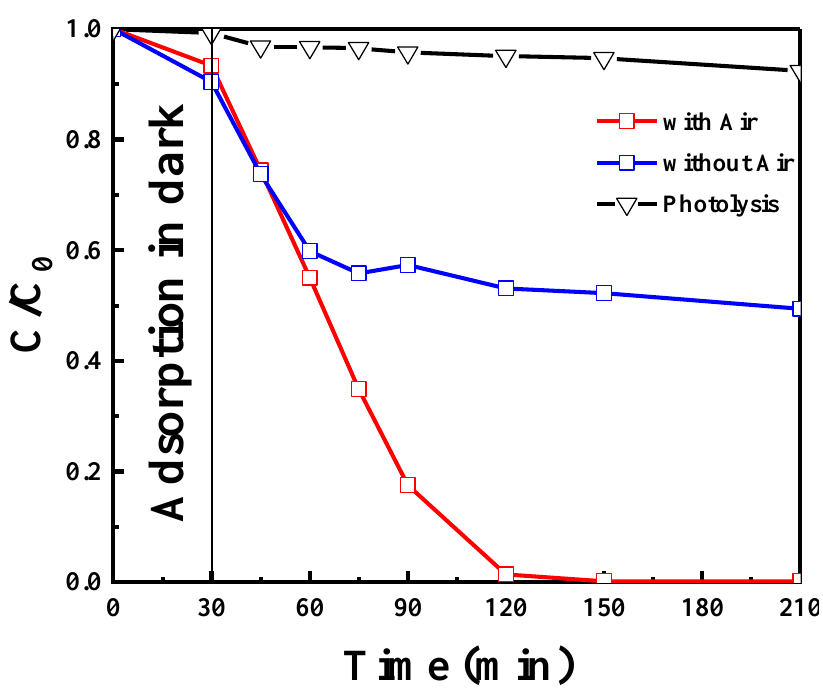
Figure 10. Photodegradation curves of phenol in the absence or presence of an airflow; C 0 = 20 ppm, airflow = 50 mL/min, catalyst = 0.5 g/L, pH = natural, light source = LEDs, Catalyst = exfoliated g-C 3 N 4 .